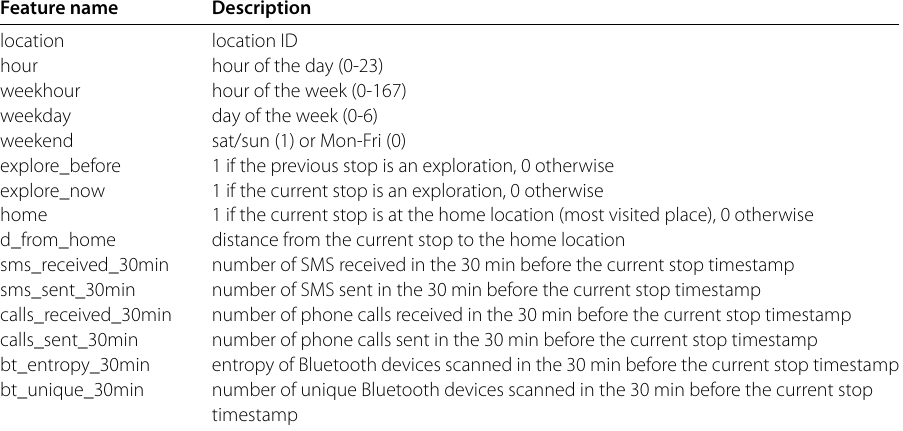
Table 1 Description of the features used for the logistic regression